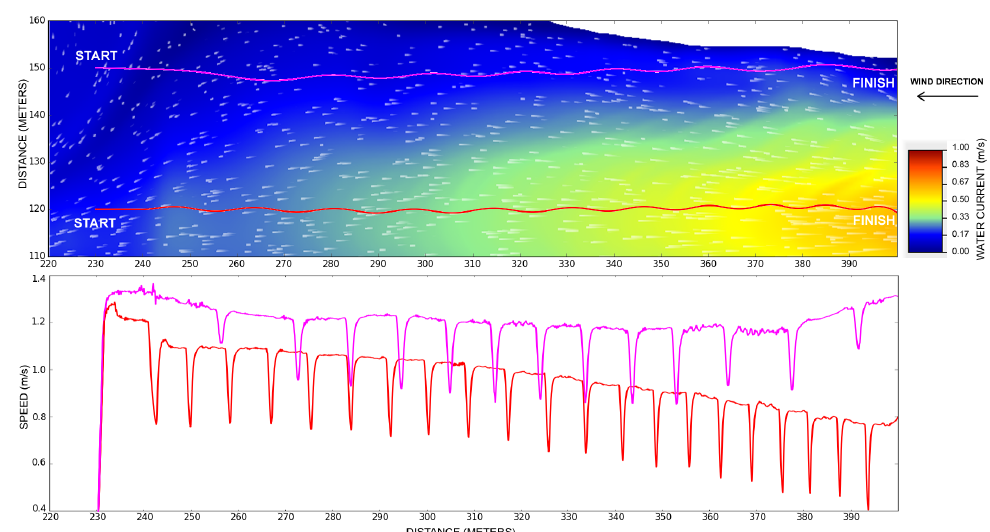
Figure 9. Different navigation speeds of the differential boat going upstream, against the river current.